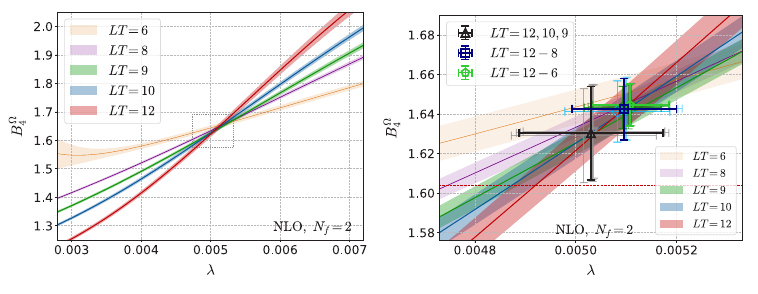
/ N 2 N 2 Figure 2. Ratio of the second-order cumulants of the baryon number and electric charge B (cid:30) c Q (cid:30) c (cid:31) (cid:31) = 200 GeV and its com- constructed from the experimental data by the STAR Collaboration at √ s NN parison with the lattice results [21].